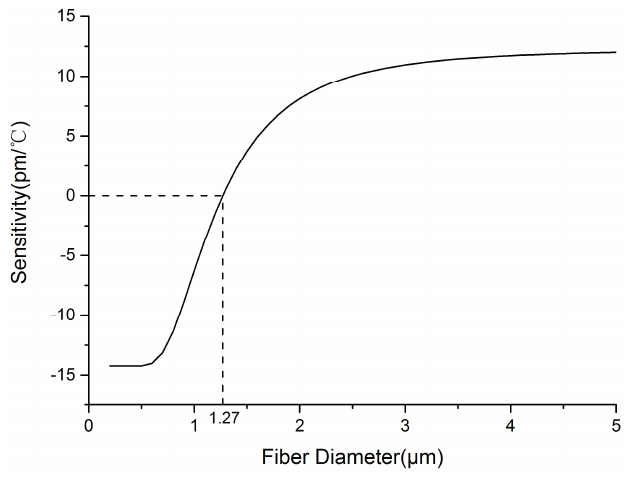
Figure 1. The simulated sensitivity dependence on fiber diameter.